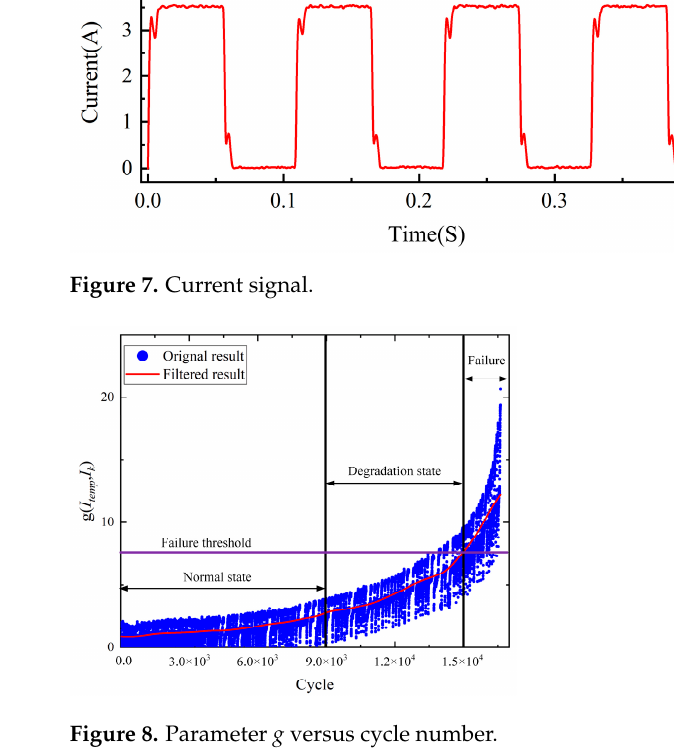
Figure 8. Parameter g versus cycle number. Table 1. Working cycles corresponding to degradation states.